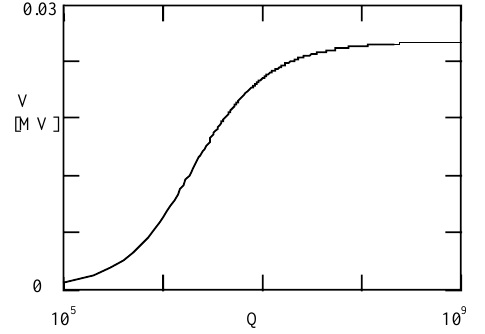
FIG. 14. The induced voltage vs (cid:81) , for (cid:115) (cid:82) (cid:121) (cid:81) (cid:100) (cid:173) (cid:49) V , a beam current of 8 mA, and a beam on time of (cid:56)(cid:48)(cid:48) m